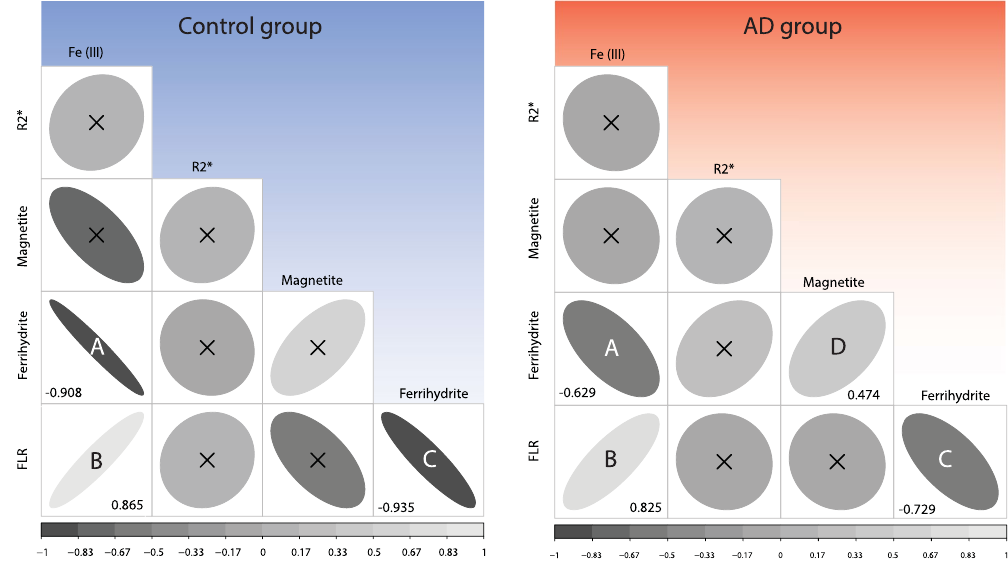
Figure 3. Correlogram of the iron forms measured in this study and grouped by diagnosis. The ellipse eccentricity and color intensity are proportional to the Spearman’s correlation coefficient for a specific pair of iron forms (see also scale bar at the bottom). Left panel refers to the control group (N = 11, after outliers were removed as explained in the Materials and Methods section) while the right panel refers to the patients group (N = 18, after outlier removal). Correlograms which are not statistically significant, i.e. p-value > 0.05, are crossed. For those correlograms with p-value < 0.05, the correlation coefficient is reported in the respective squares. Letters are used to facilitate the comparison between pairs of